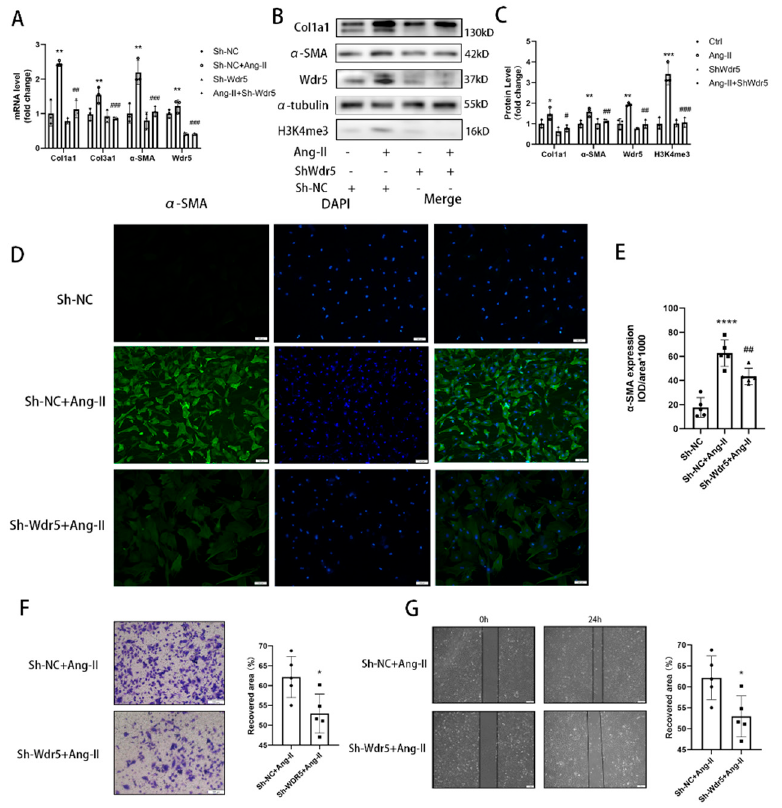
Figure 4. Genetic knockdown Wdr5 suppressed Ang-II-induced FMT process. ( A ) Application of Sh-Wdr5 repressed the Ang-II-induced col1a1, col3a1, and α -SMA in mRNA levels and achieved 60% knockdown of Wdr5 mRNA. ( B ) Protein levels of col1a1 and α -SMA were downregulated after transfection of Sh-Wdr5 by lentivirus ( n = 4 in each group). ( C ) is the quantitative analysis of graph ( B ). ( D ) Immunofluorescence analysis of α -SMA demonstrated inhibited α -SMA by Sh-Wdr5 (green, α -SMA; blue, DAPI, Scale bar 100 µm) and ( E ) is the quantitative statistics of graph ( D ) ( n = 5 in each group, >3 fields in each sample). ( F ) Representative images of transwell migration assay and the quantification of migrated NRCFs after transfected with Sh-NC or Sh-Wdr5 ( n = 5 in each group, >3 fields in each sample). ( G ) Wound repair assays were performed to assess the migratory capacities of cells that have been transfected with Sh-NC or Sh-Wdr5 ( n = 5 in each group, >3 fields in each sample). Scale bar 100 µm. Data are presented as mean ± SEM. * p < 0.05, ** p < 0.01, *** p < 0.001, **** p < 0.0001 vs. saline, # p < 0.05, ## p < 0.01, ### p < 0.001 vs. Ang-II group.